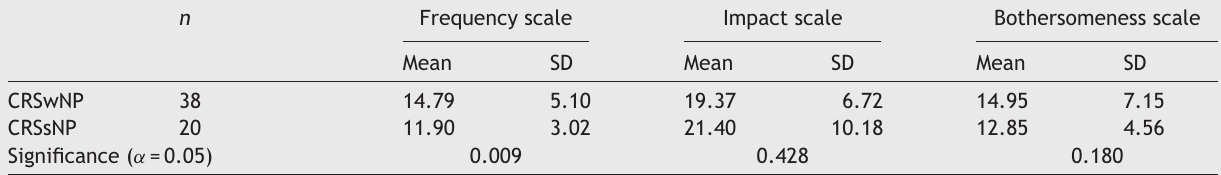
Total score by type of CRS for each sub-scale.